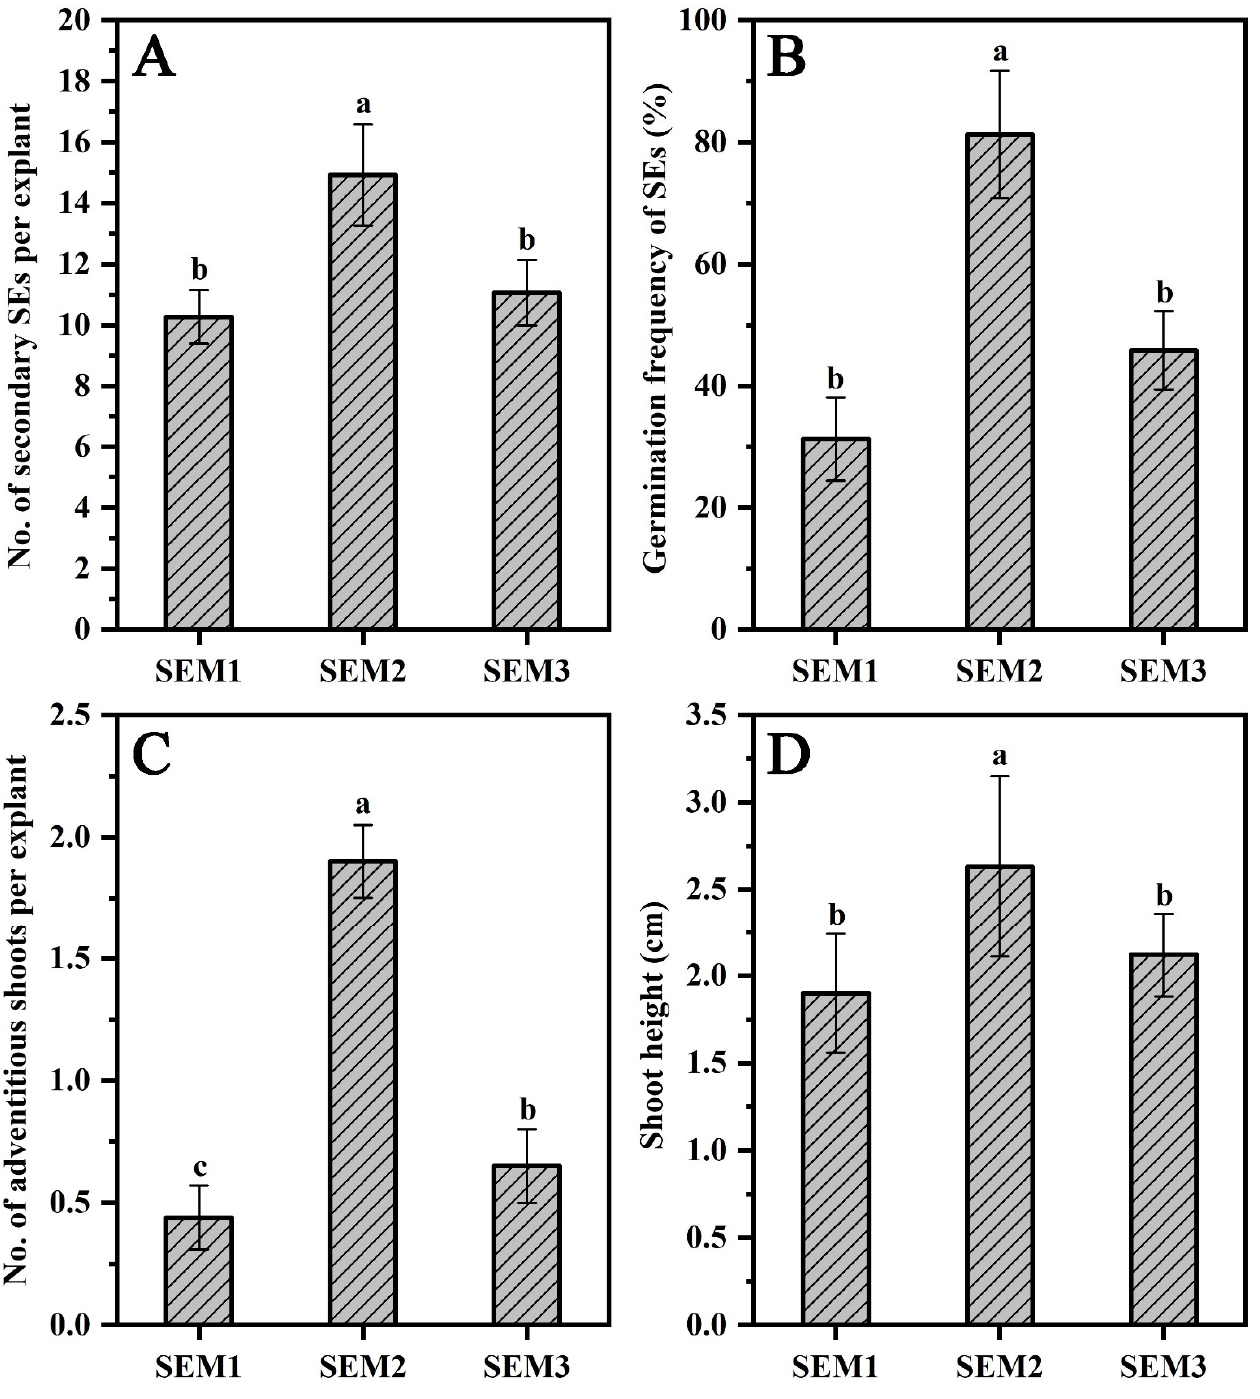
Figure 2. Effects of different concentrations of 6-BA, including 0.5 (SEM1), 1.0 (SEM2), and 2.0 mg L − 1 of 6-BA (SEM3), on the number of secondary SEs per explant ( A ), the germination frequency of SEs ( B ), the number of adventitious shoots per explant ( C ), and the shoot height ( D ). Different letters indicate significant differences at the 5% level via Duncan’s range test ( n = 9).